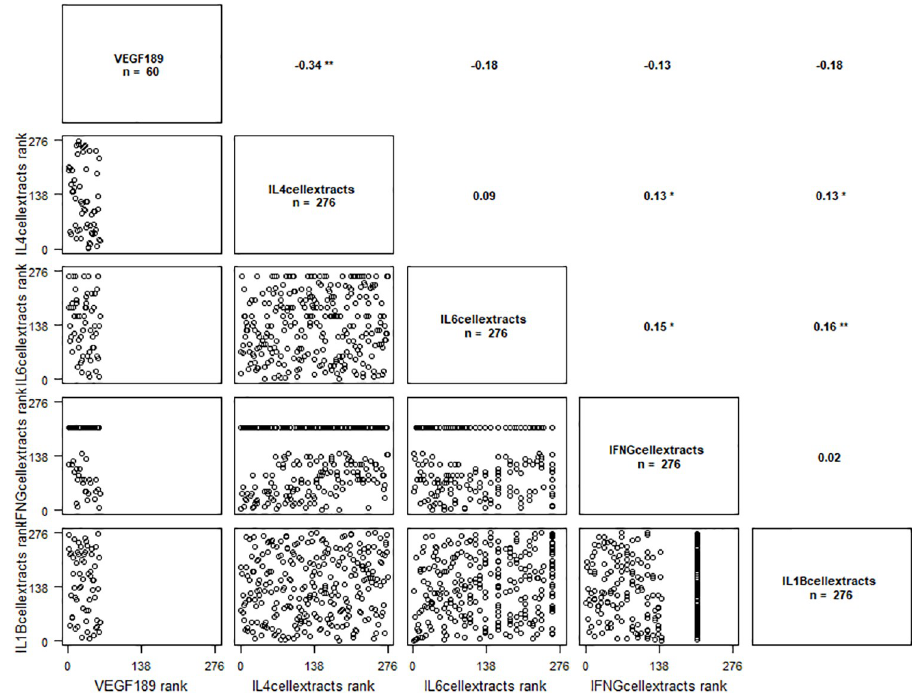
Fig 5. Correlation graph between VEGF levels. ‘ �� ’ p � 0.01, ‘ � ’p � 0.05.